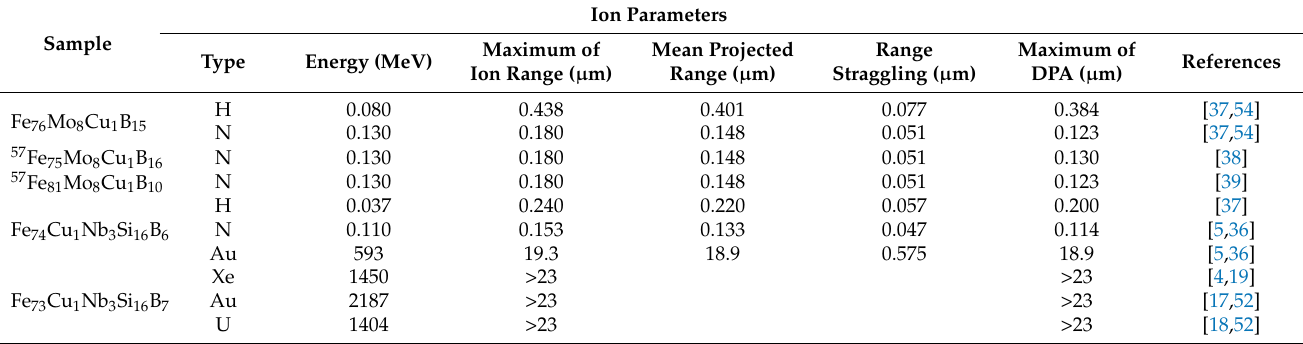
Table 2. Parameters of ion irradiation